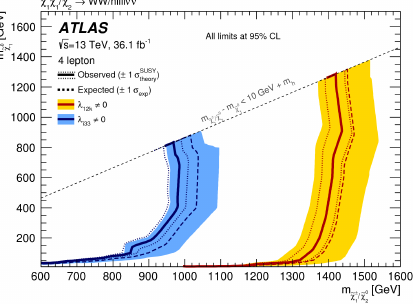
Figure 20: ˜ g NLSP [ 21 ] .